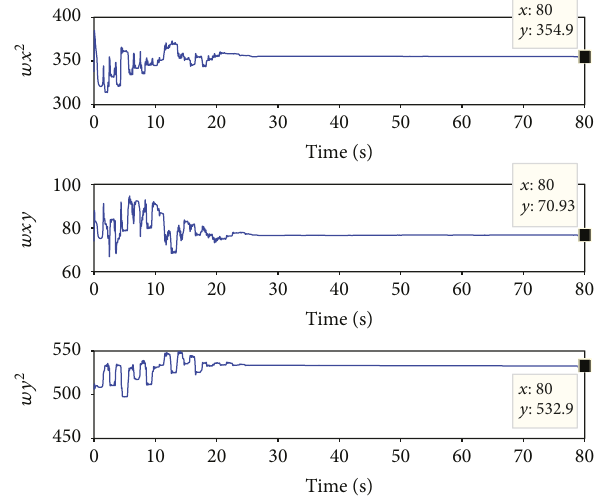
Figure 7: Fractional-order nonsingular terminal sliding surface.